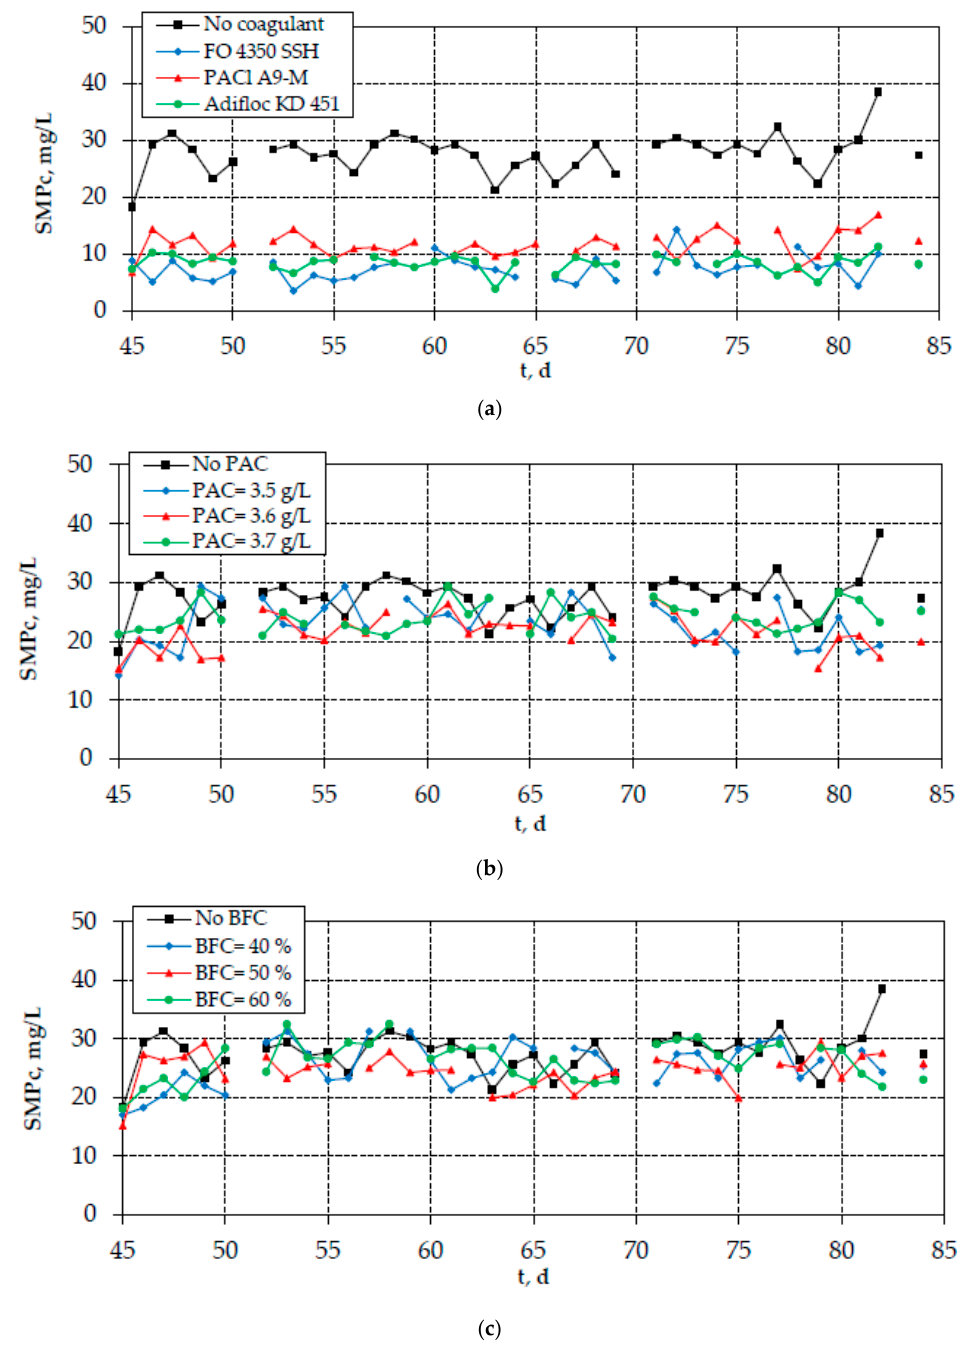
Figure 4. Evolution of SMP c in the mixed liquor after the addition of (a) optimal coagulation agents FO 4350 SSH (10 mg/L), PACl A9-M (100 mg Al/L), and Adifloc KD 451 (10 mg/L); (b) optimal PAC concentrations (3.5–3.7 g/L); and (c) bio-film carriers (BFCs) (40%, 50%, and 60%).